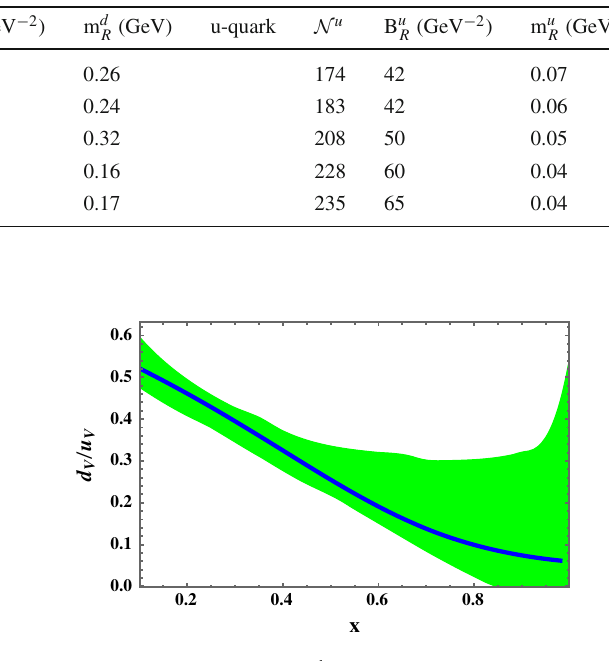
Fig. 14 The x dependence of d V ratio in valence quark region, u V solid curve. The calculation is compared with the one following from CT14nnlo parametrization. The area takes into account the spread of the PDFs for d- and u-quark distributions